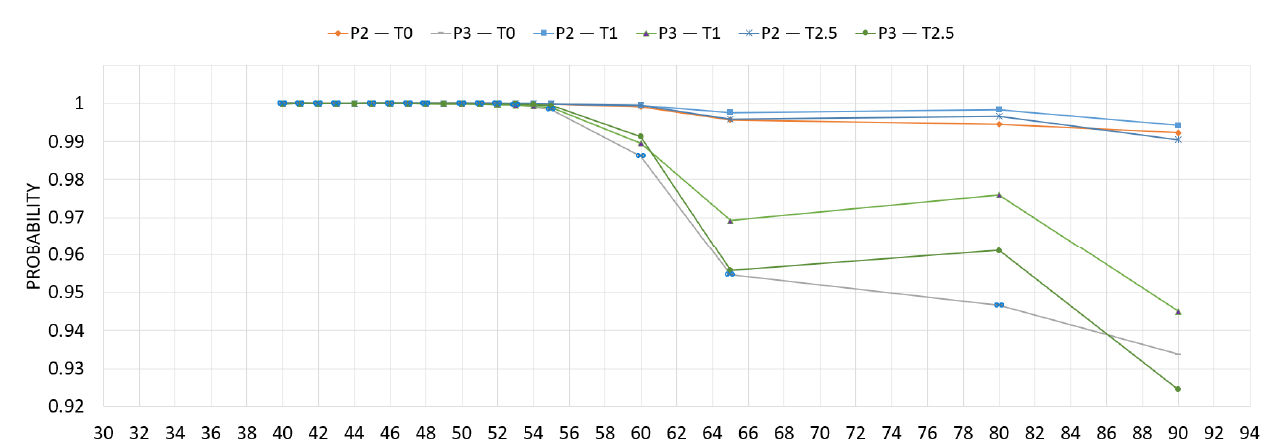
Figure 14. ( a ) Longitudinal ventilation comparison with V T = 0 m/s. ( b )—Transverse ventilation comparison with V L = 2.5 m/s for probabilistic injury. P2 and P3 refer to the probability of second and third burn injuries, respectively.